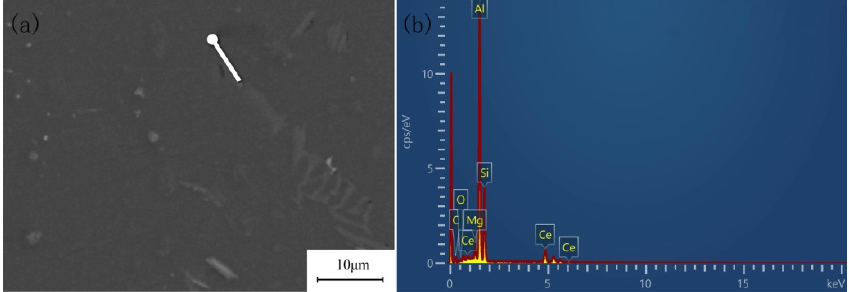
Figure 16. (AlSiFeCe) phase in A357 alloy. ( a ) Detecting position, ( b ) EDS analysis, ( c ) Line scanning position, ( d ) Al element, ( e ) Si element, ( f ) C element, ( g ) Mg element, ( h ) Ce element.